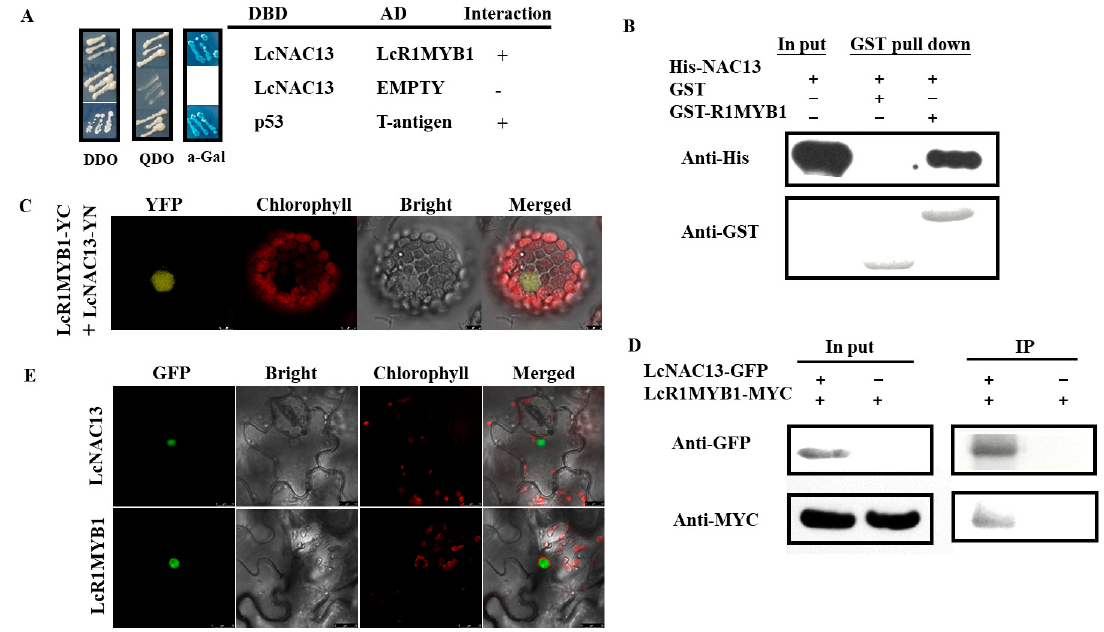
Figure 4. Interaction between LcNAC13 and LcR1MYB1 in vitro and in vivo. ( A ) Interaction between LcNAC13 and LcR1MYB1 in the Y2H assay. ( B ) Interaction between LcNAC13 and LcR1MYB1 in vitro in the GST pull-down assay. ( C ) Interaction between LcNAC13 and LcR1MYB1 by bimolecular fluorescence complementation in Arabidopsis mesophyll protoplasts. ( D ) Interaction between LcR1MYB1 and LcNAC13 in the coimmunoprecipitation assay. ( E ) Subcellular localization of LcNAC13 and LcR1MYB1 in tobacco ( Nicotiana benthamiana ) leaves. Green signal indicates GFP fluorescence; yellower signal indicates YFP fluorescence; red signal indicates chlorophyll autofluorescence. The merged images represent digital combination of the chlorophyll autofluorescence and YFP fluorescent images or GFP fluorescent images. Scale bar = 10 μ m.